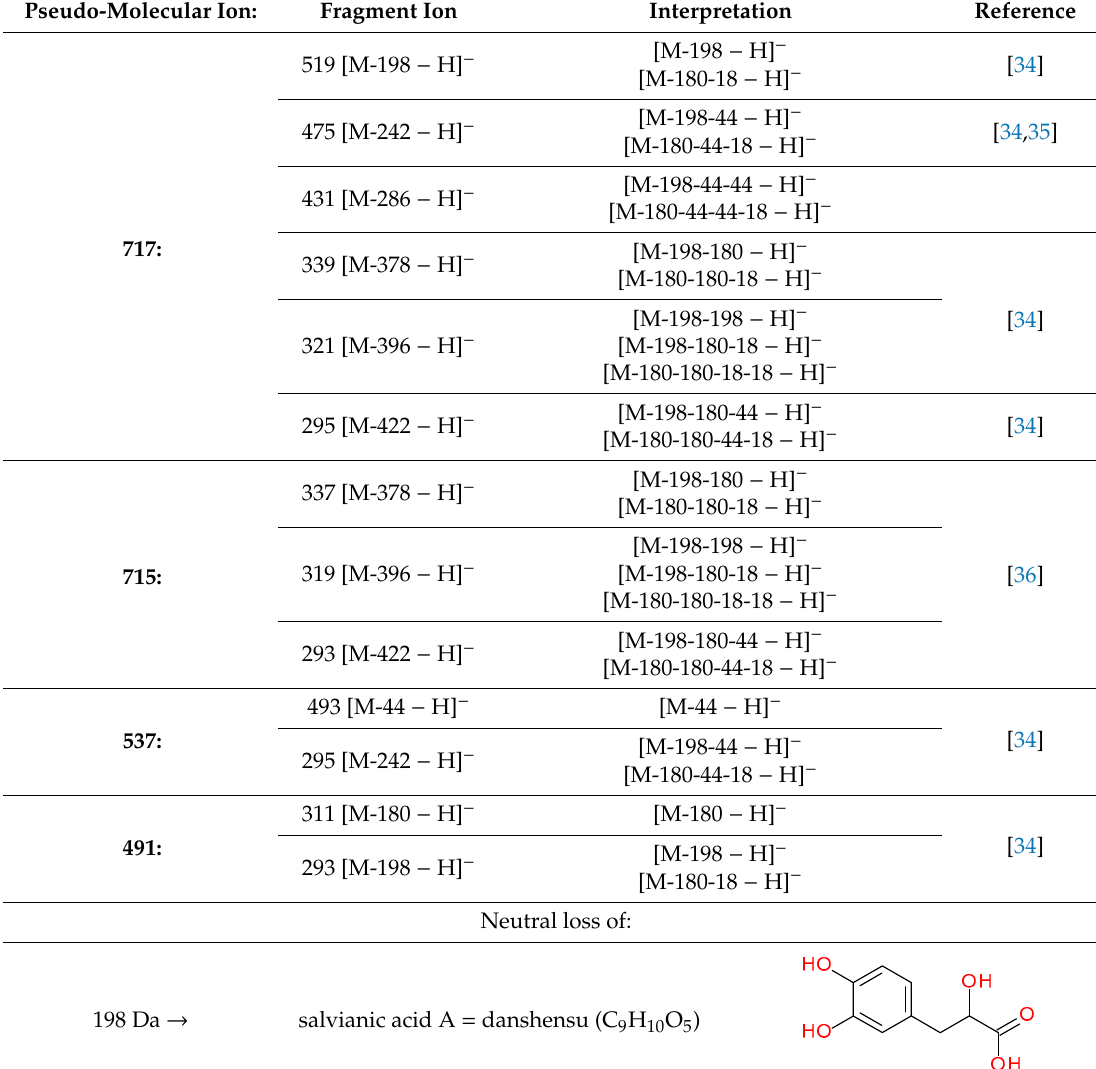
Table 2. Analysis of fragmentation behaviors of trimeric and tetrameric caffeetannins.